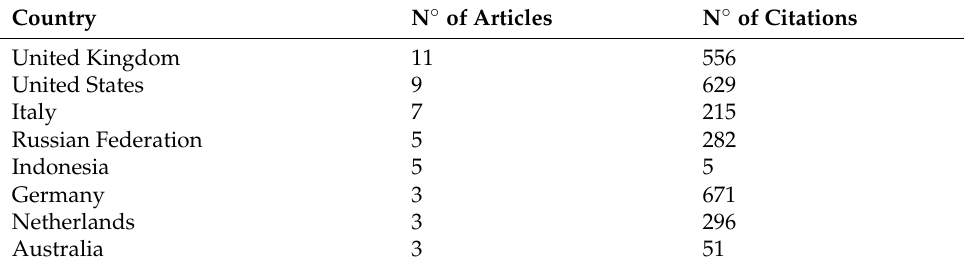
Table 2. N ◦ of analyzed articles and citations by countries.